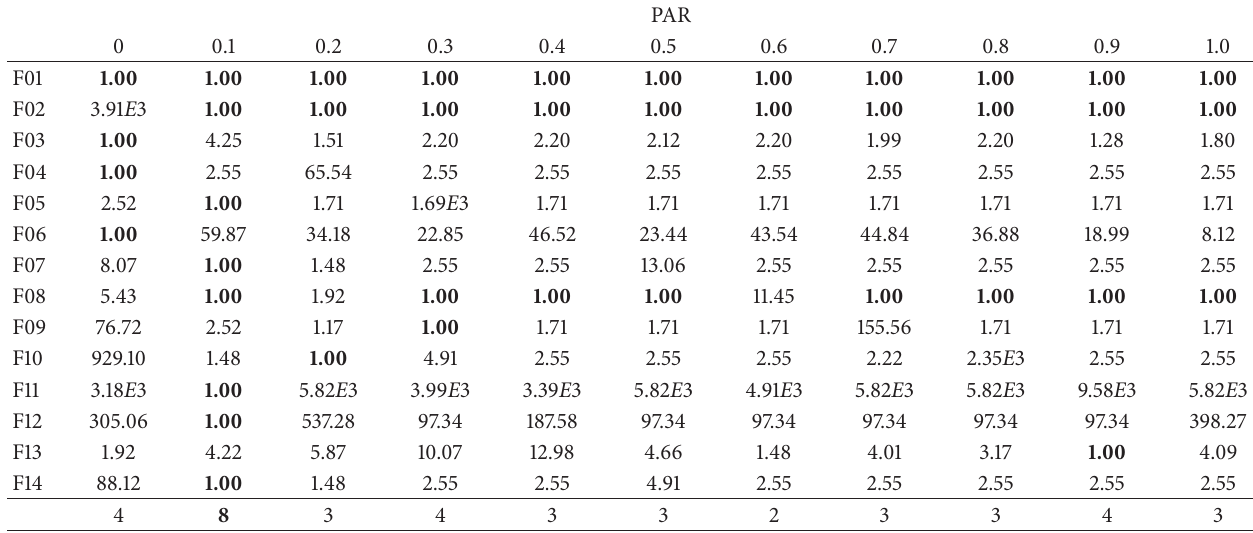
Table 11: Best normalized optimization results in fourteen benchmark functions with different PAR. The numbers shown are the best results found after 100 Monte Carlo simulations of HS/BA